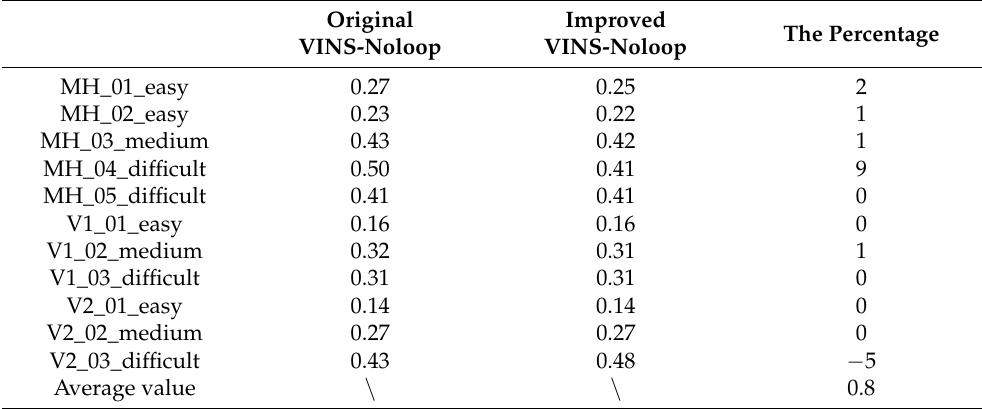
Table 11. Percentage of accuracy improvement between the original algorithm and the optimized algorithm without loopback (unit: meter).